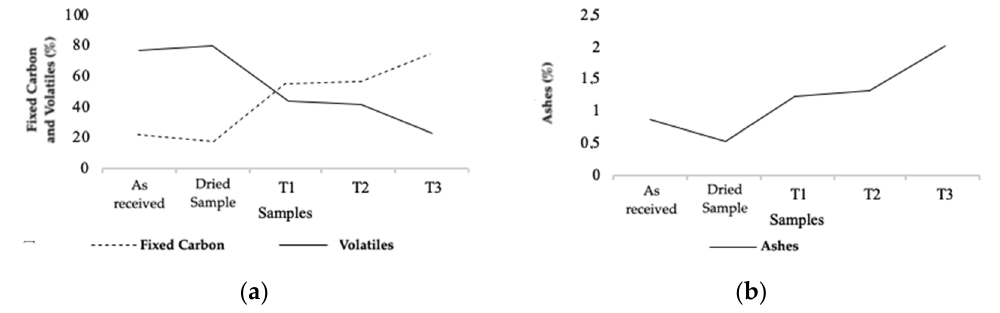
Figure 6. Fixed carbon and volatile content ( a ), and ash content ( b ) from TGA of natural, dry, and